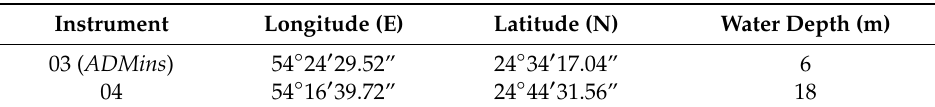
Table 2. Coordinates of the positions of the two instruments installed by the Abu Dhabi Municipality (ADM) and the relative water depth.